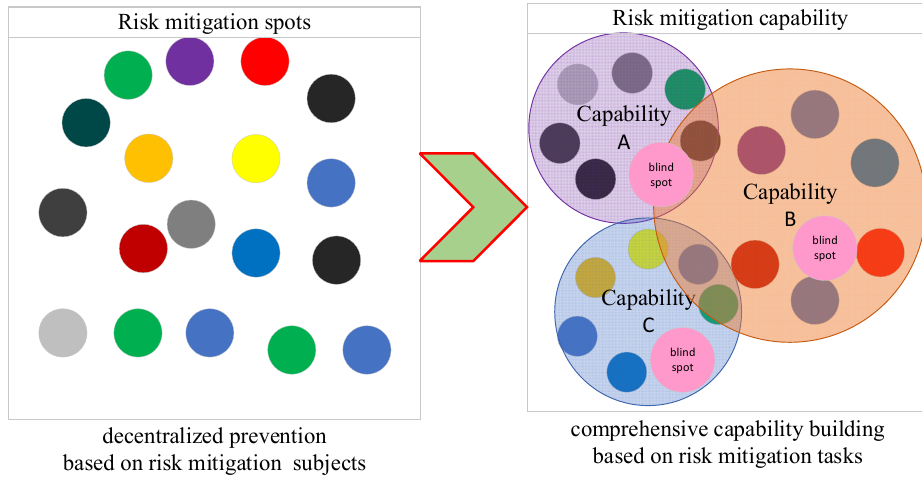
Figure 2. The comprehensive security system theory core